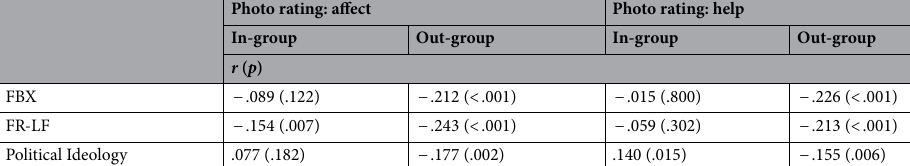
Table 4. Correlations between state empathy and measures of xenophobia and conservatism in the in-group and out-group condition. FBX fear-based xenophobia, FR-LF right wing extremist attitudes; political orientation (1 = left, 7 =